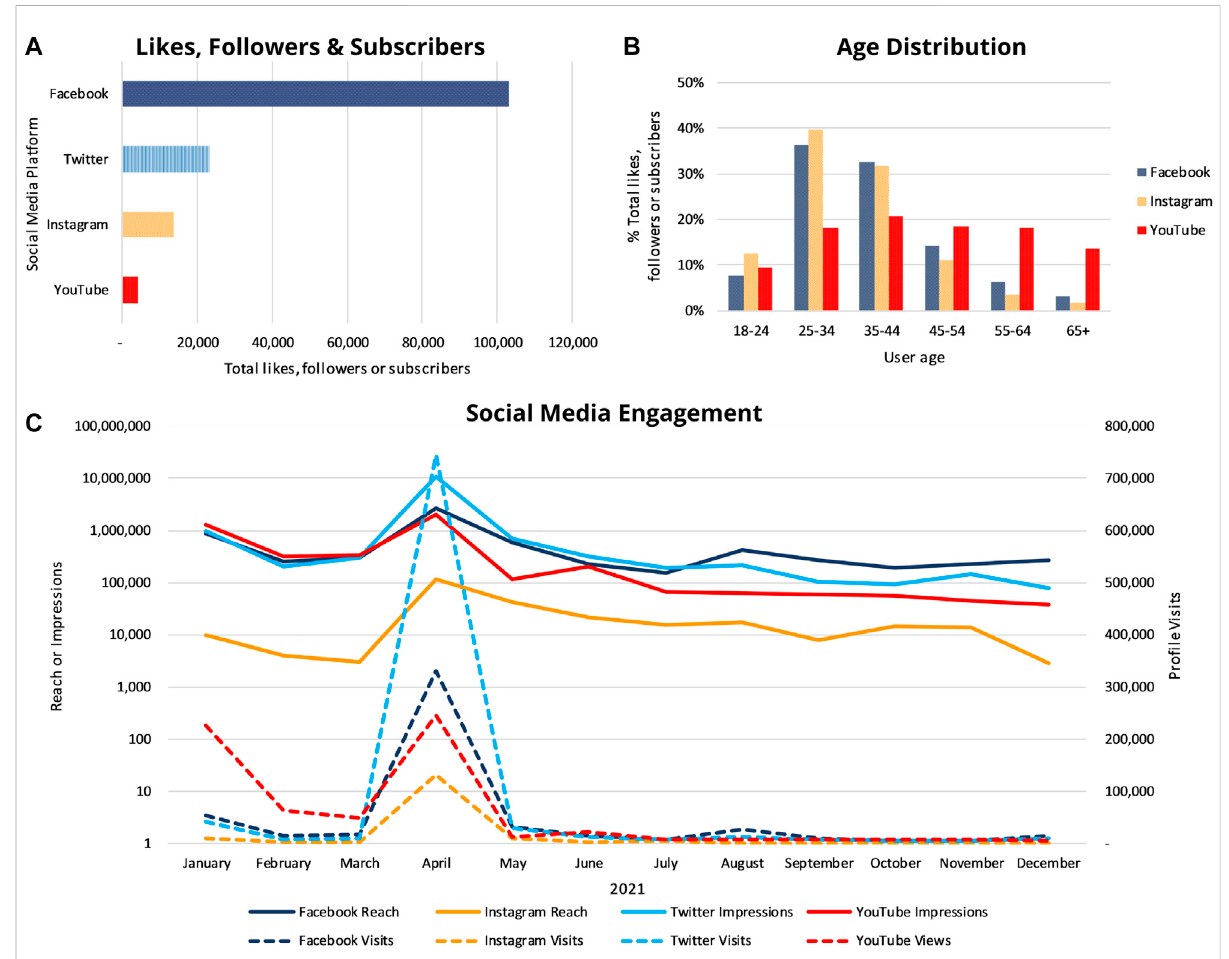
FIGURE 2 Summary of selected UWI Seismic Research Centre social media metrics. (A) Total likes, followers and subscriptions to UWI-SRC social media account. (B) Social media followers/subscribers age distribution. (C) Pro fi le visits and impressions/reach (feed appearances) in 2021. Social media engagement peaked in April at the start of explosive activity at La Soufrière, St.